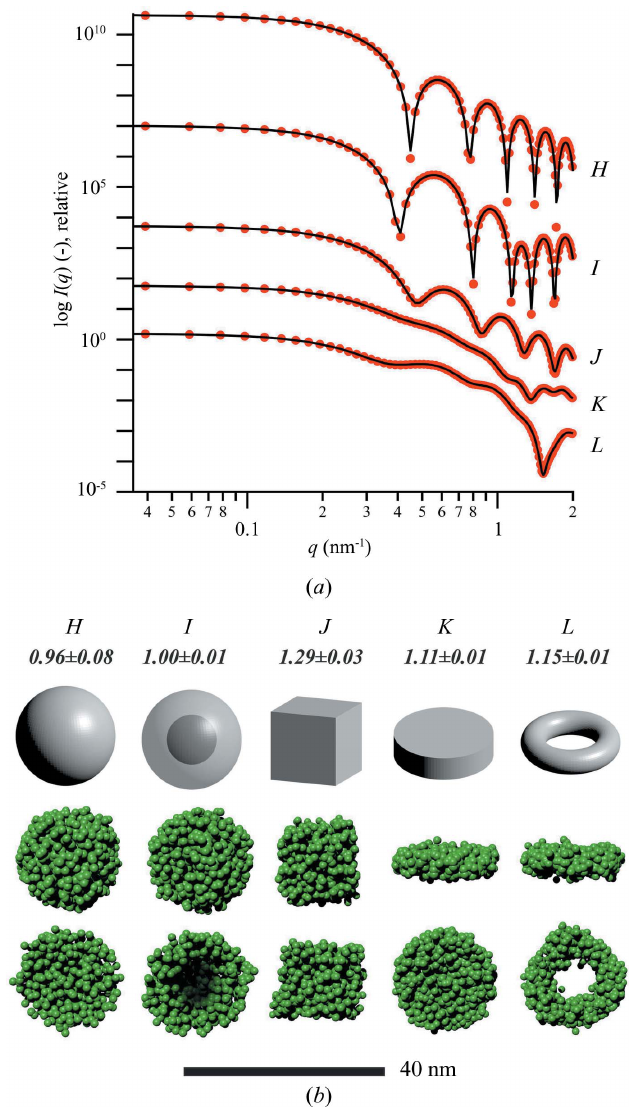
Figure 4 ( a ) Scattering curves computed from globular model geometries (red circles; see Appendix A for model details) and fits from the reconstruc- tion (black lines). For better visualization, the scattering patterns are shifted vertically and error bars have been omitted. The PDDFs of all models can be found in Fig. S12. ( b ) Theoretical and reconstructed three- dimensional models of the globular geometries used here (see Fig. S16 for point representations of the reconstructions). The numbers below the labels denote the mean normalized spatial discrepancy h NSD i , obtained from eight independent reconstructions (random artificial sphere: h NSD i = 1.04 (cid:7) 0.01, random artificial cube: h NSD i = 1.06 (cid:7)